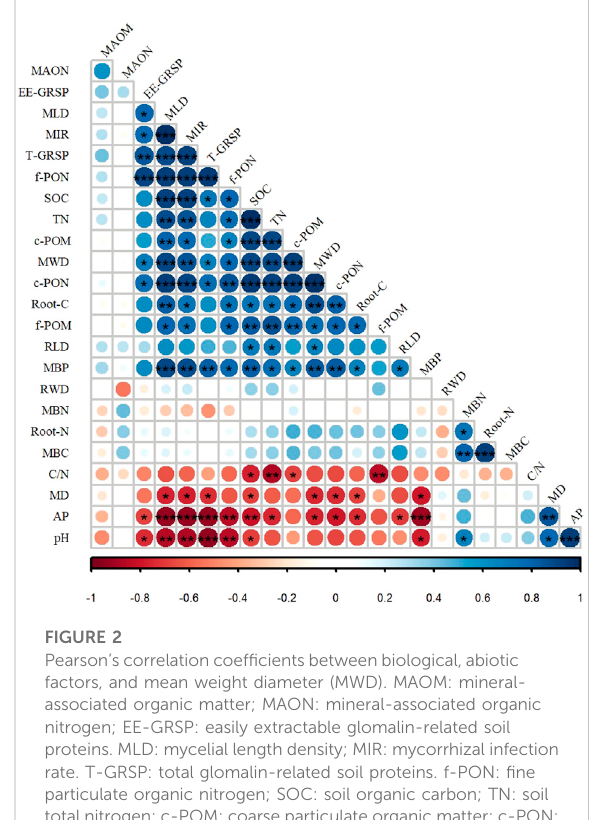
FIGURE 2 Pearson ’ s correlation coef fi cients between biological, abiotic factors, and mean weight diameter (MWD). MAOM: mineral- associated organic matter; MAON: mineral-associated organic nitrogen; EE-GRSP: easily extractable glomalin-related soil proteins. MLD: mycelial length density; MIR: mycorrhizal infection rate. T-GRSP: total glomalin-related soil proteins. f-PON: fi ne particulate organic nitrogen; SOC: soil organic carbon; TN: soil total nitrogen; c-POM: coarse particulate organic matter; c-PON: coarse particulate organic nitrogen; root-C: carbon content inthe fi neroots;f-POM: fi neparticulateorganicmatter;RLD:rootlength density; MBP: microbial biomass phosphorus; RWD: total root weight density; MBN: microbial biomass nitrogen; root-N: nitrogen content in the fi ne roots; MBC: microbial biomass carbon; C/N: the ratio of carbon and nitrogen; MD: mean root diameter; and AP: available phosphorus. The asterisks indicate signi fi cant correlations. Blue represents a positive correlation, and red represents a negative